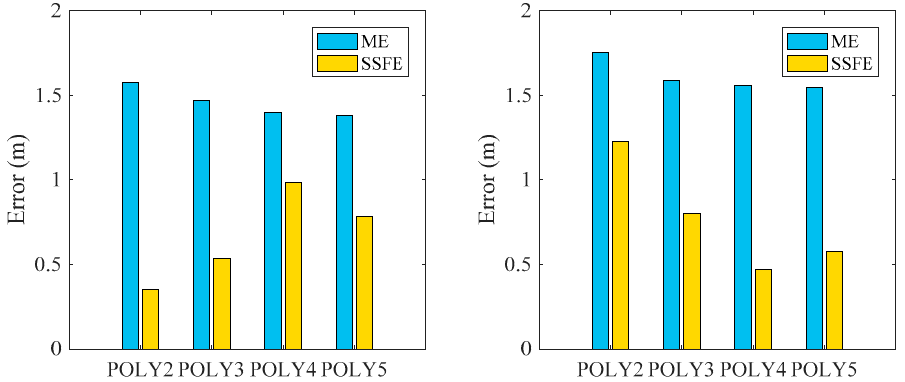
Figure 4. Mean error (ME) and sum of the square fluctuation errors (SSFE) of the n th-degree polynomial: ( left ) first fitting result; ( right ) second fitting result.